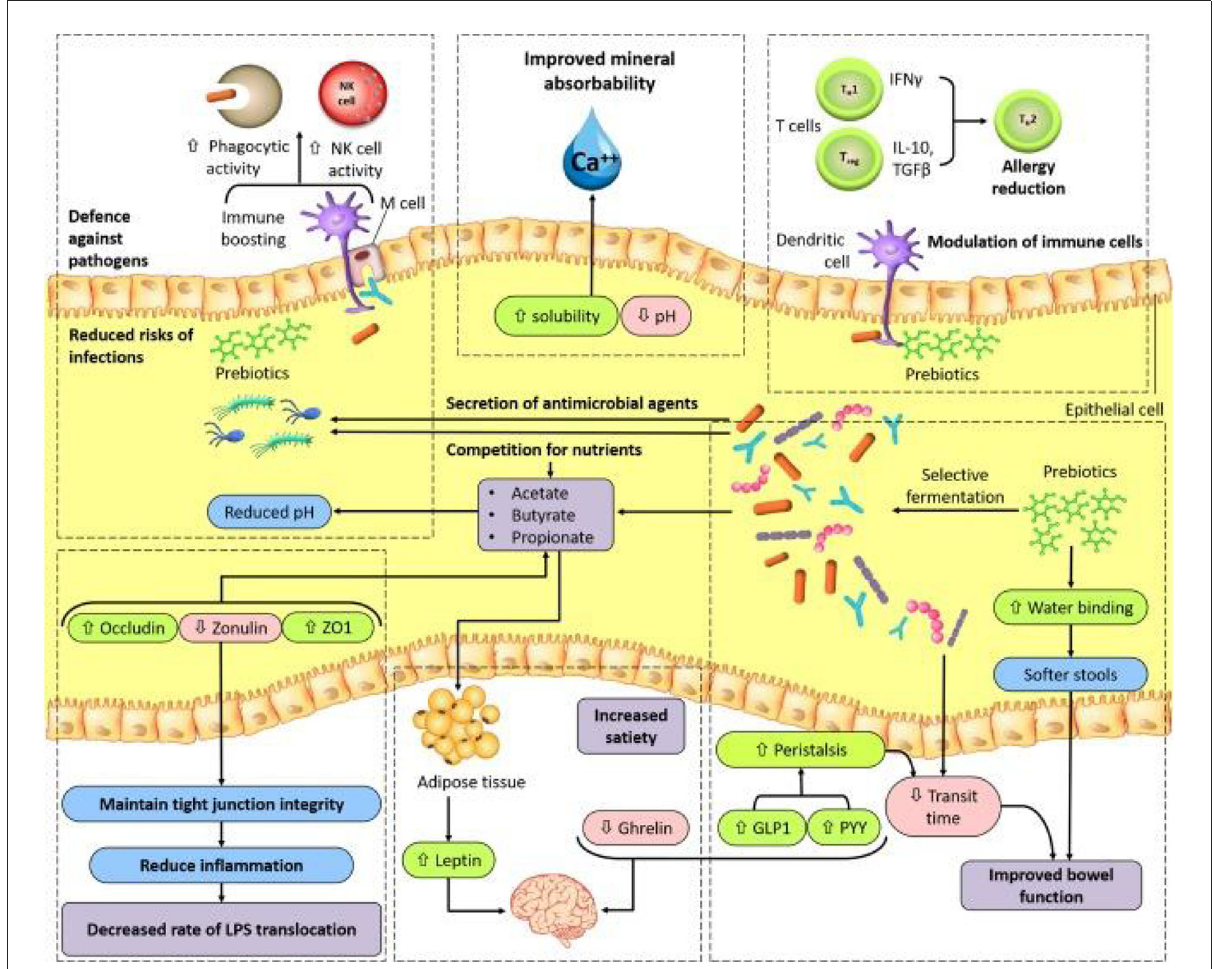
FIGURE2 A model for possible mechanisms of prebiotic benefits to human health (66). GLP1, glucagon like peptide1; M cell, microfold cell; NK, natural killer; PYY, peptide YY; TGF β , transforming growth factor- β ; TH1, TH2, type 1T helper, type 2T helper; Treg, regulatory T; ZO1, zonula occludens